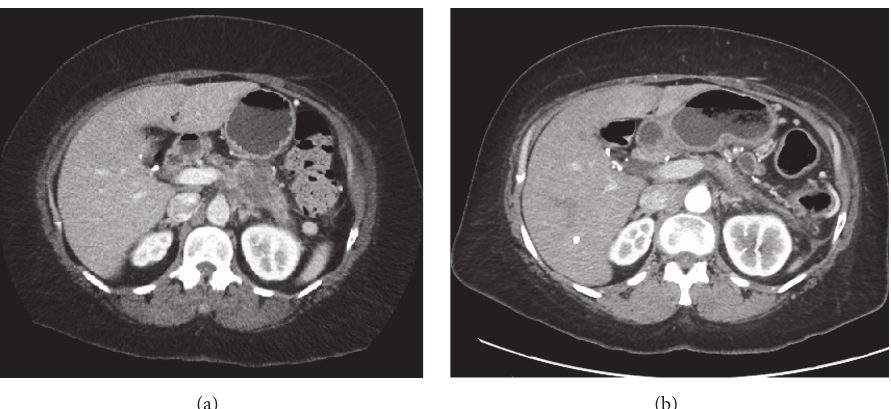
Figure 1: (a) Axial CT demonstrating large mass in body/tail of pancreas before neoadjuvant therapy. (b) Axial CT demonstrating tumor response after neoadjuvant